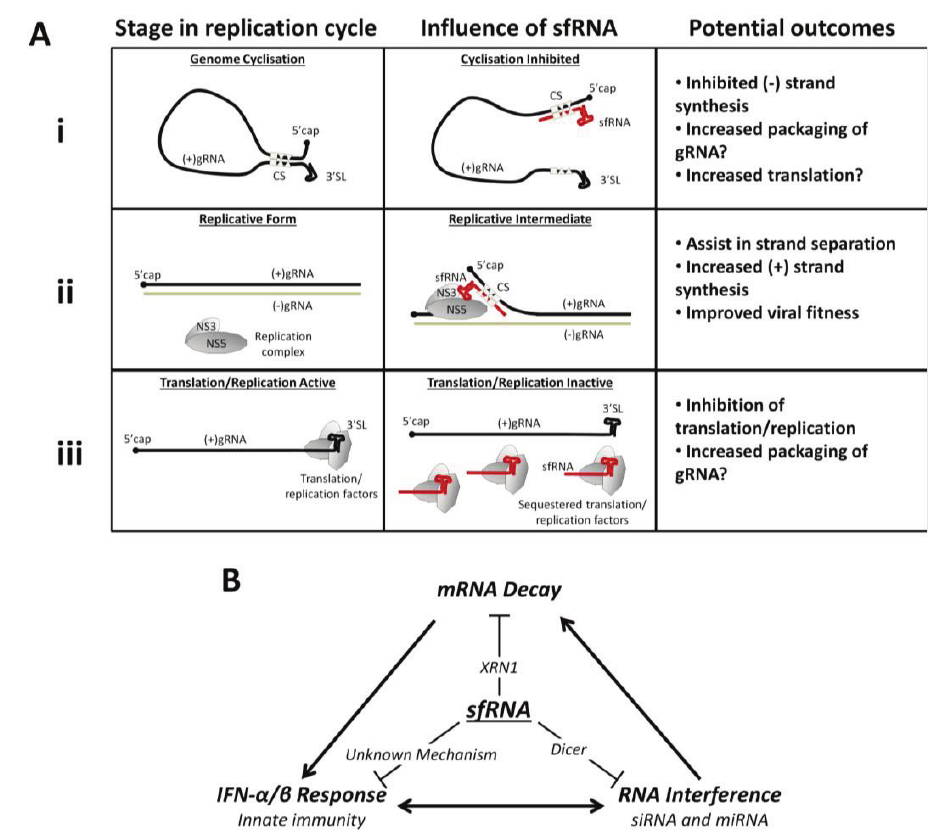
Figure 4. Proposed models of sfRNA interactions in viral replication and the host response. ( A ) Potential influences of sfRNA on viral gRNA replication: ( i ) sfRNA may prevent gRNA cyclisation, inhibiting ( – ) strand synthesis; ( ii ) sfRNA may interact via cyclisation sequences to assist in unwinding dsRNA in the replicative form at the (+) strand 5' end, this may promote increased (+) strand synthesis; ( iii ) sfRNA may competitively bind and sequester translation and/or replication factors, inhibiting translation and replication of gRNA; ( B ) Different host response pathways inhibited by sfRNA: sfRNA interaction with XRN1 disrupts host mRNA decay; sfRNA suppresses host RNAi pathways likely through interaction with Dicer; sfRNA inhibits the IFN- α/β response via an unknown mechanism. Each of these pathways cross-communicates and may influence the activities of the